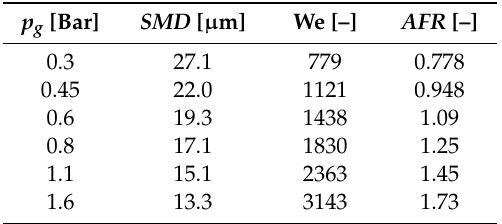
Table 4. Estimated properties of diesel oil atomization at various p g .